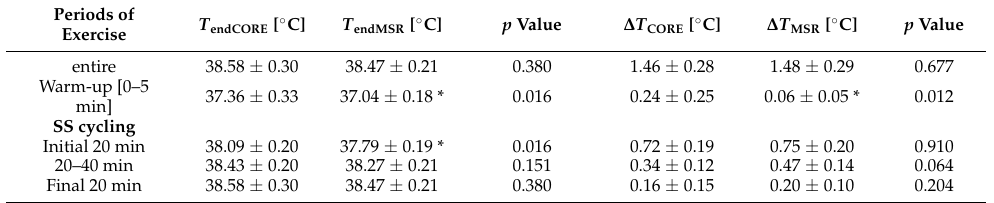
Table 4. Mean temperatures during the last 30 sec of Study I, as well as of the corresponding phases of exercise, as determined with the CORE sensor ( T endCORE ) and MSR rectal sensor ( T endMSR ). The fourth and fifth columns report the increase in total temperature increase during each period.